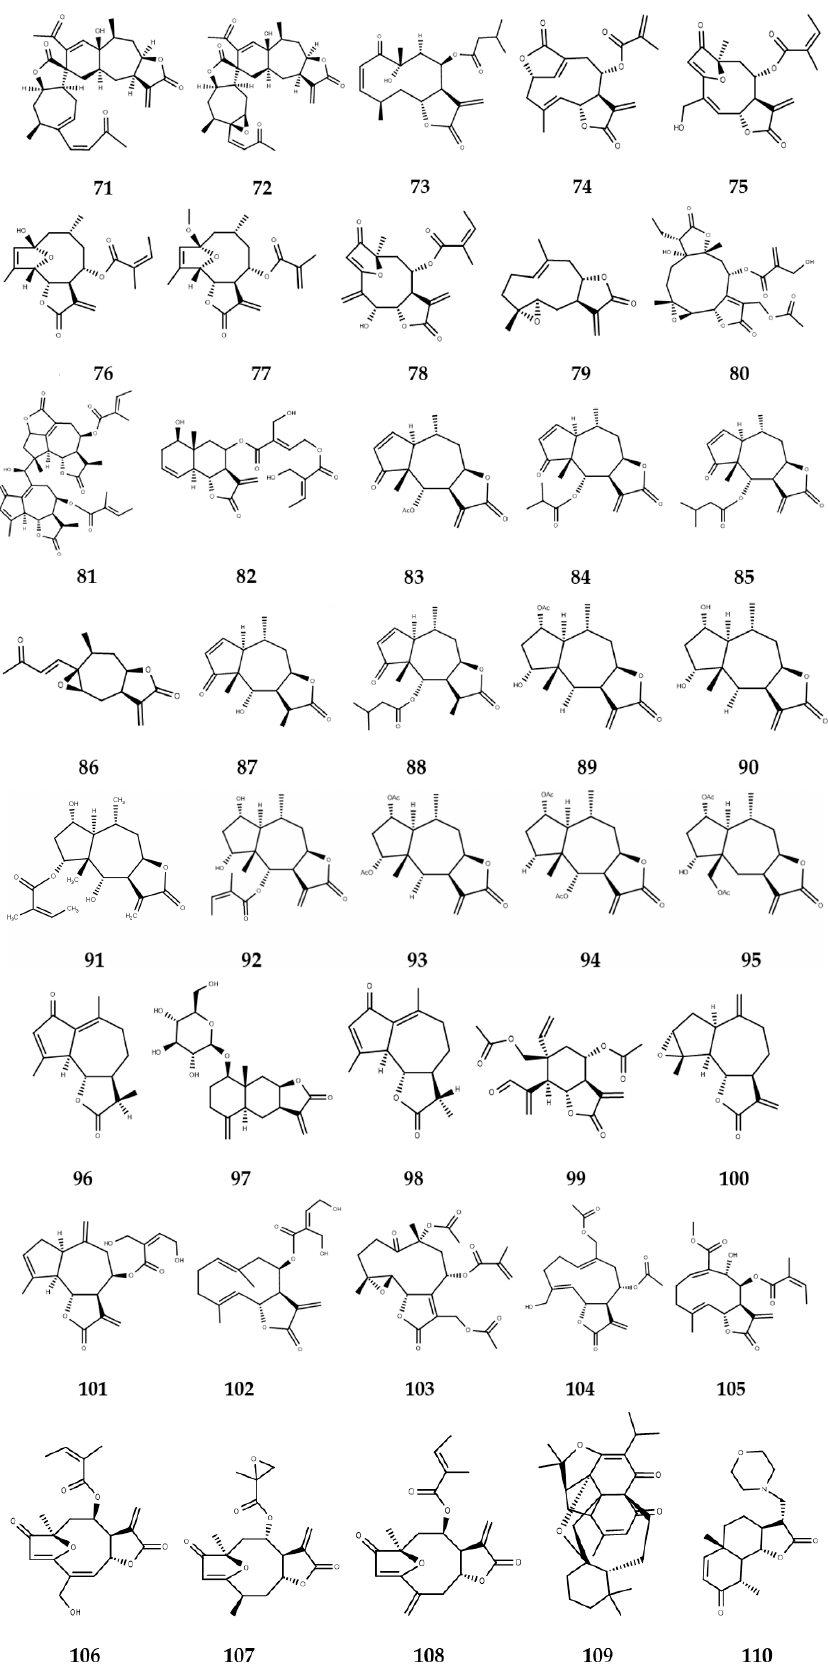
Figure 4. Sesquiterpene lactones studied by in silico methodologies.